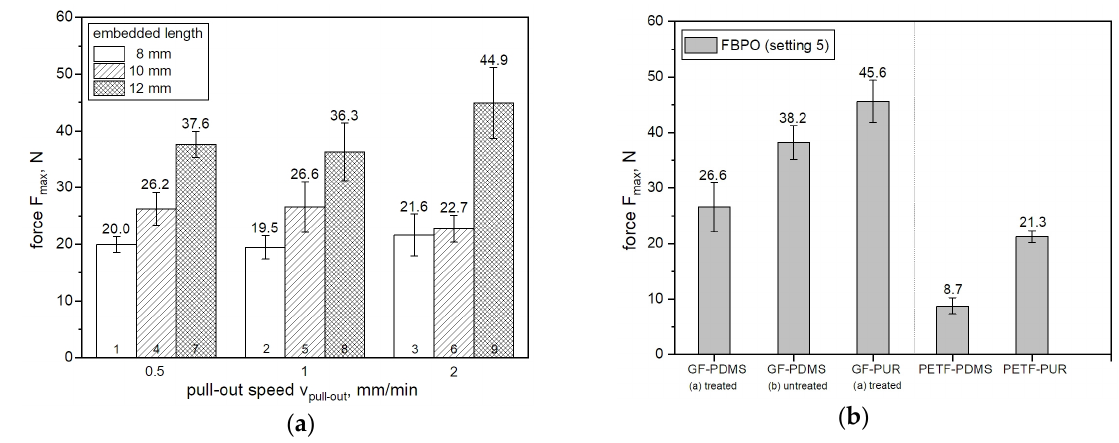
Figure 4. Influence of the parameters on the pull-out force for GF and PDMS matrix ( a ) and on different reinforcement-matrix material combinations tested on reference setting ( b ).